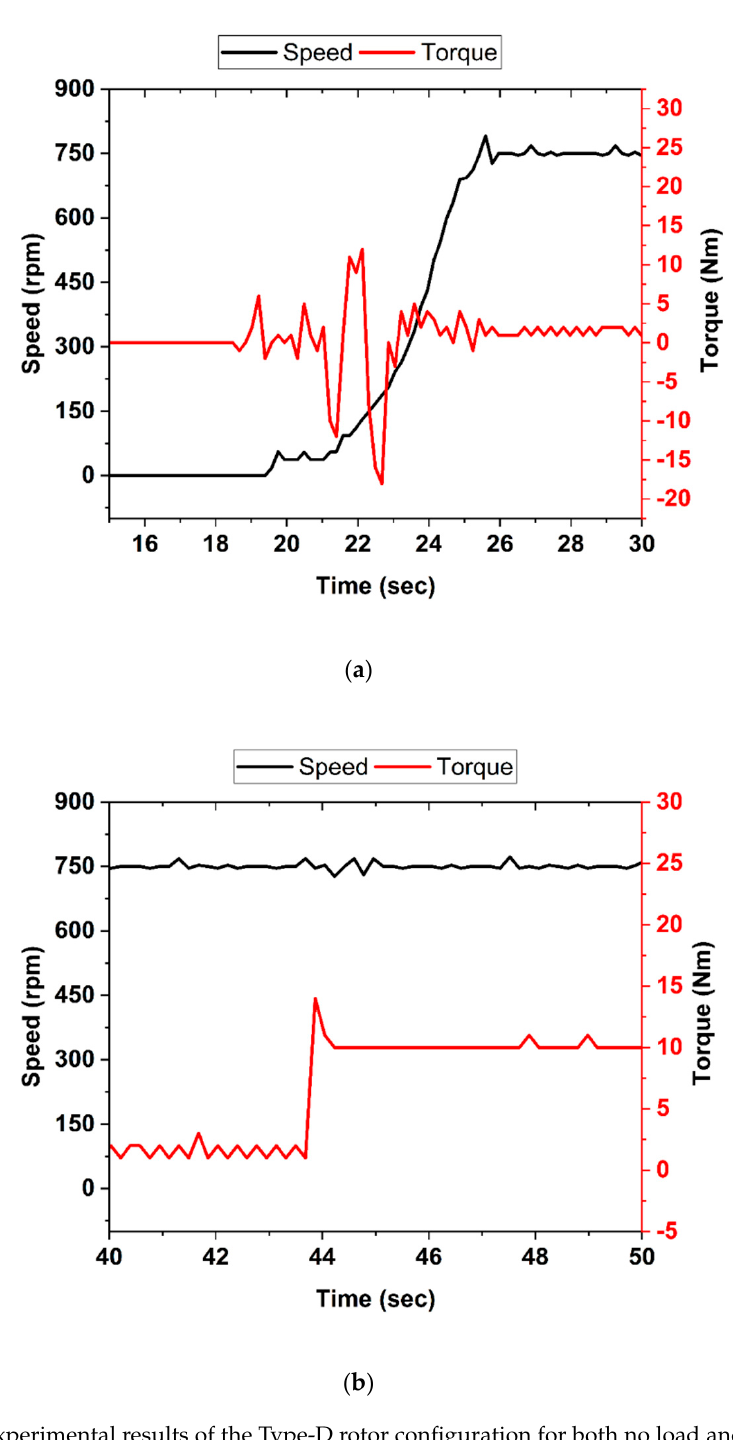
Figure 10. Experimental results of the Type-D rotor configuration for both no load and under rated load. ( a ) Line-startup with no load operation. ( b ) Application of 10 Nm for rated power.